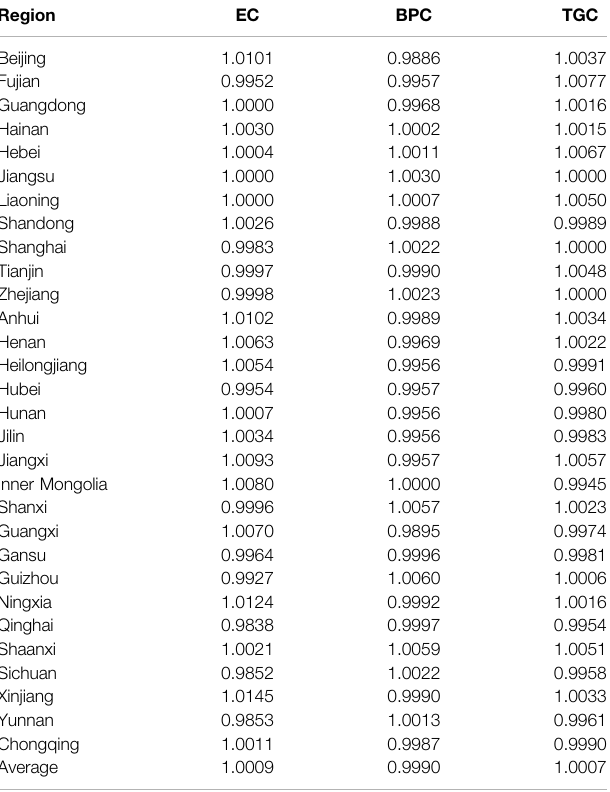
TABLE 4 | Decomposition results of MMUEI index. Region